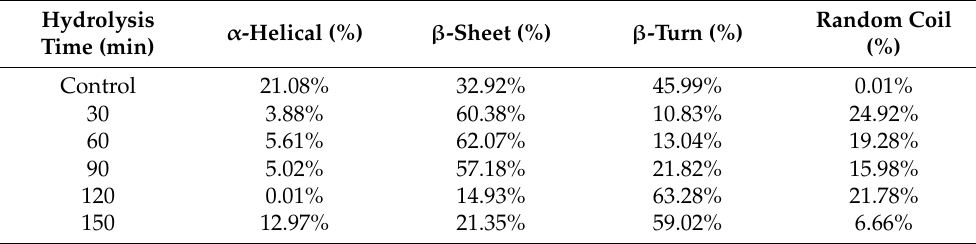
Table 4. The secondary structure contents of different WIP hydrolysates calculated from FTIR